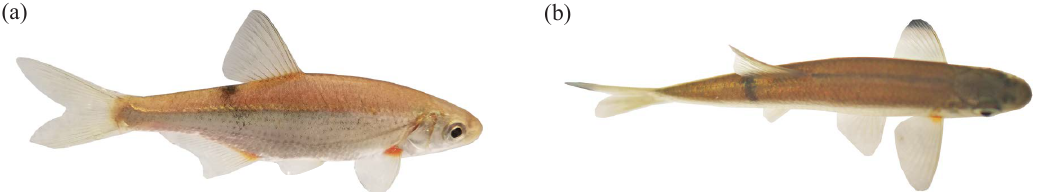
Figure 13. Injured spirlin ( Alburnoides bipunctatus ). Dark colorations of the skin behind the dorsal fin after passage of the electrified rack. ( a ) Side and ( b ) top views.